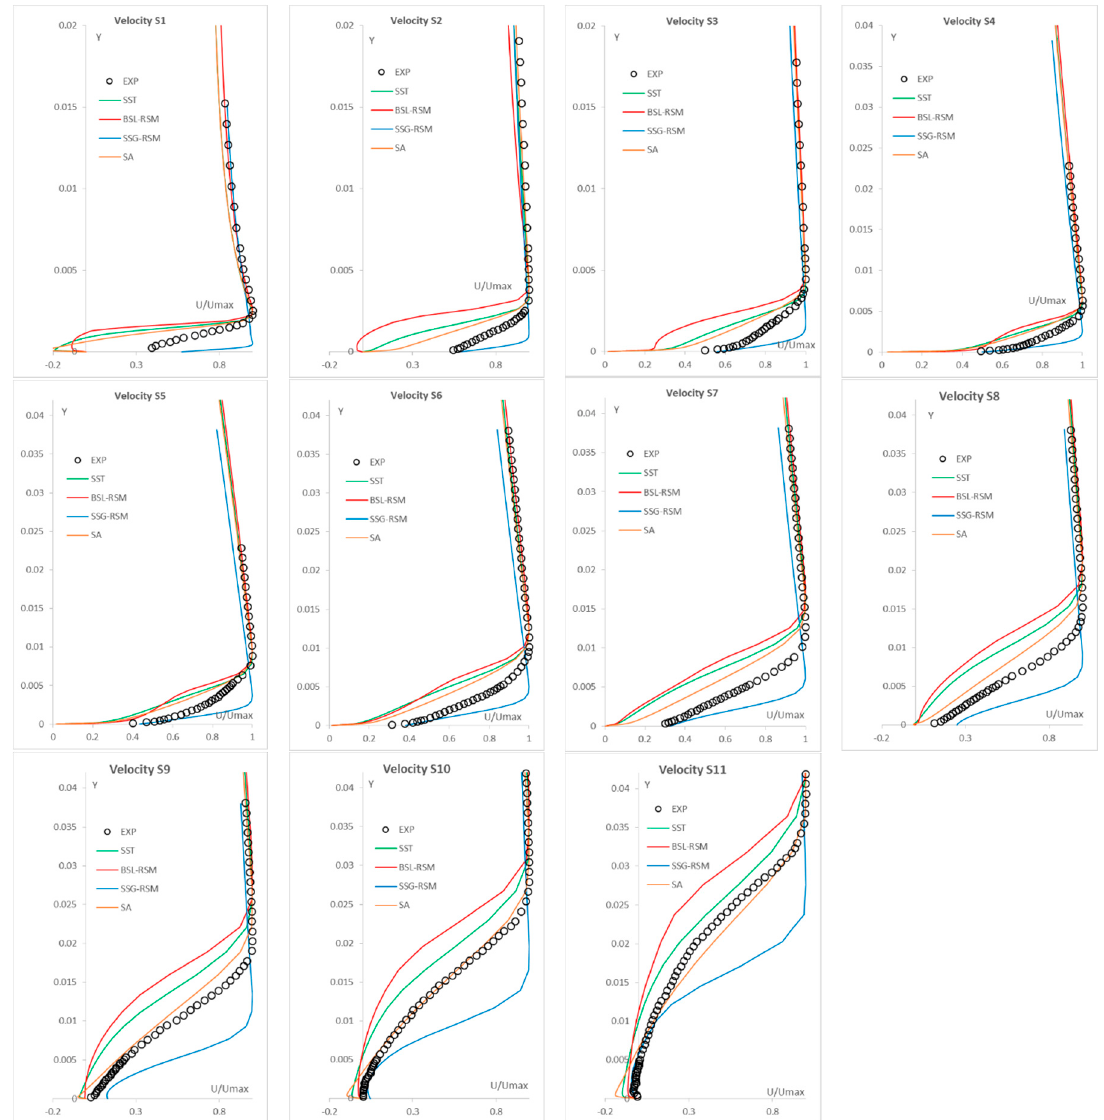
Figure 7. Velocity distributions on the DCA suction side.